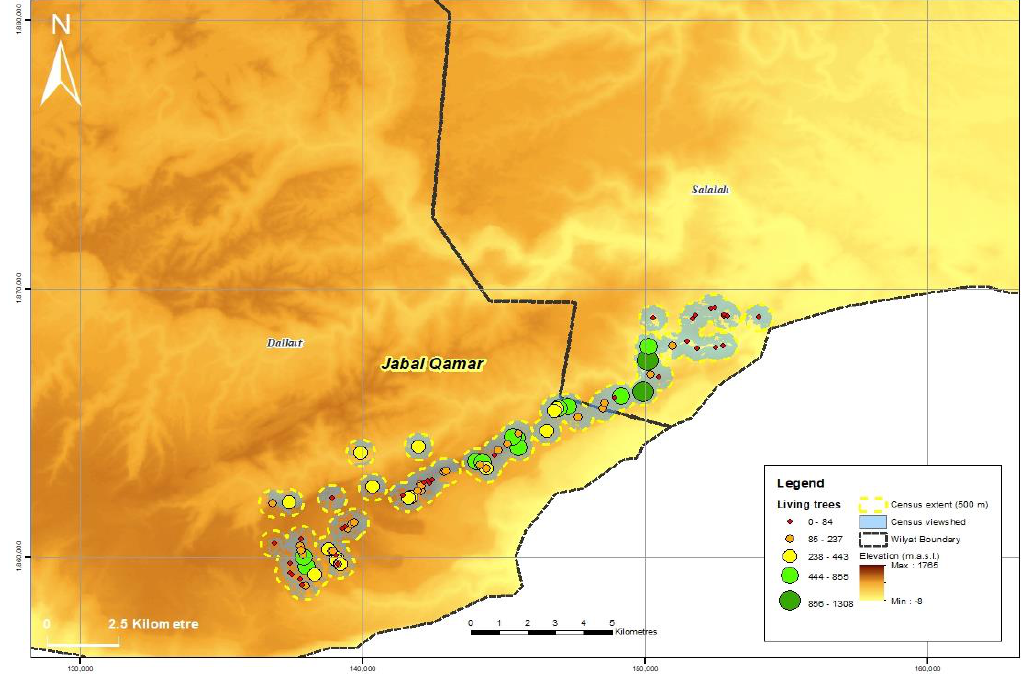
Figure 4. Distribution of census survey points, viewshed areas (depicted in blue within the dashed yellow lines), and total tree numbers on Jabal al Qamar, southern Oman, January 2018.